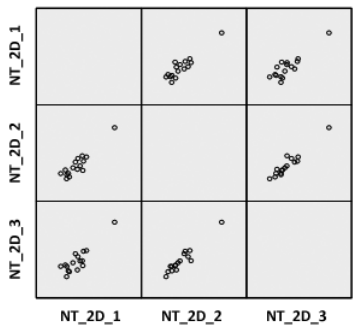
Fig. 5 - Histogram of three dimensional ultrasound nuchal translucency thickness distributions.